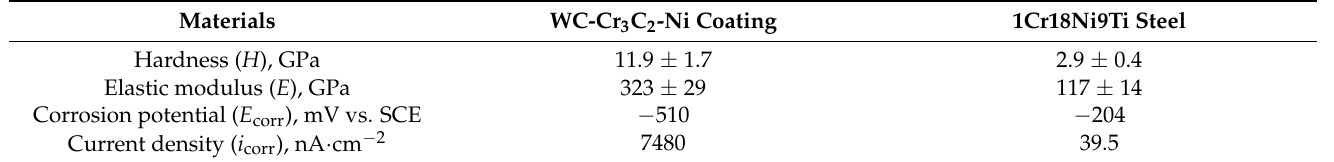
Table 2. Mechanical properties and some electrochemical characteristics.